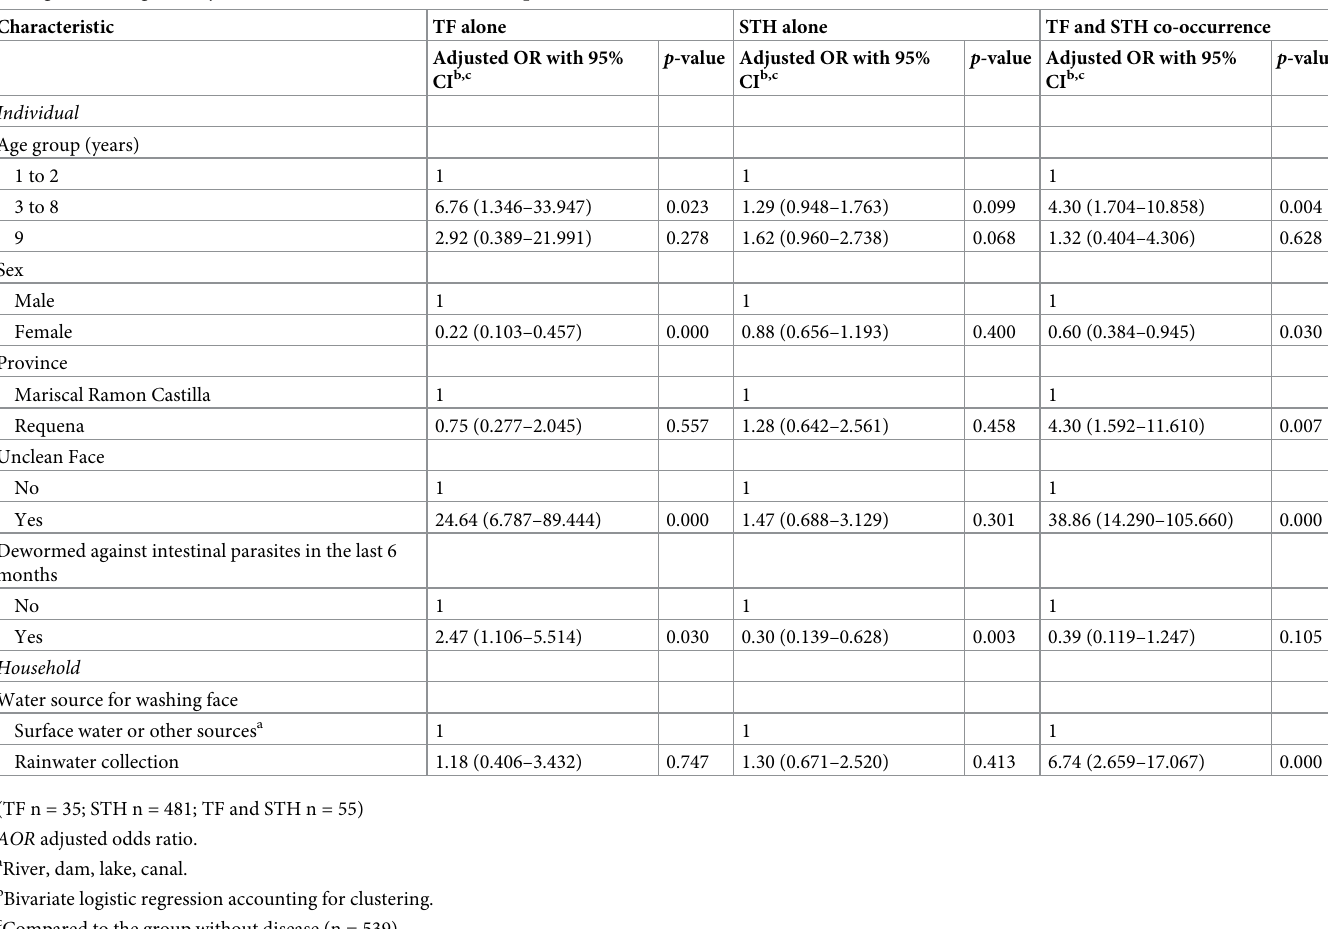
Table 10. Multinomial logistic regression analysis of factors associated with trachomatous inflammation-follicular (TF), and soil-transmitted helminthiasis (STH), among children aged 1–9 years, rural communities of Loreto Department, Peru